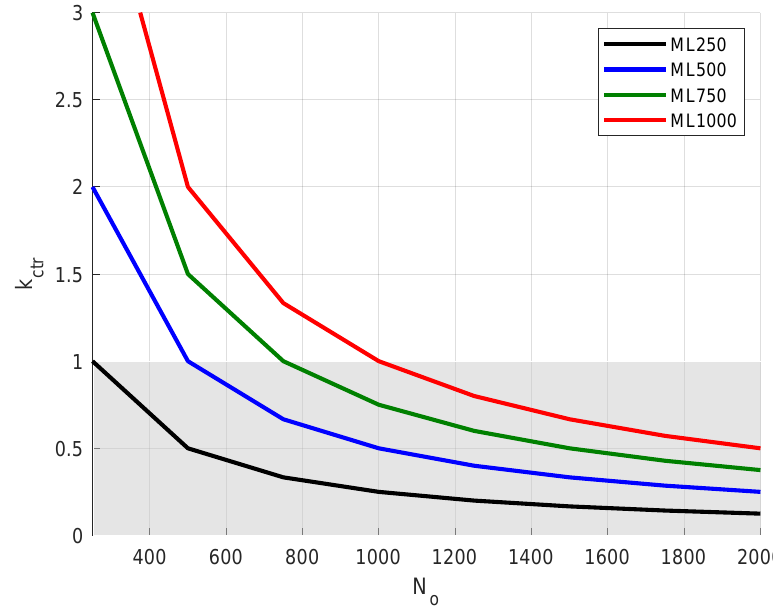
Figure 11. Machine learning model vs. FEA computational efficiency